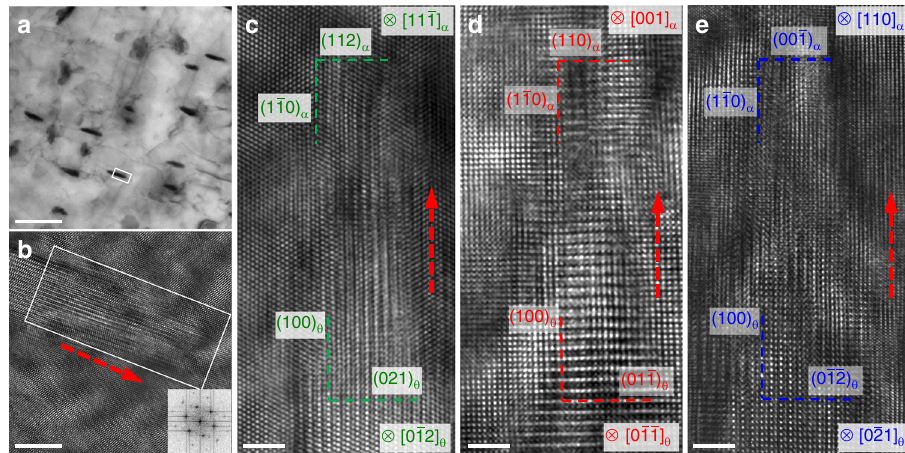
Fig. 1 Cementite nanoprecipitates in ferrite matrix. a Needle-shaped nanoprecipitates of cementite (black) with preferential growth direction in a ferrite matrix (gray). b An HRTEM image of the cementite precipitate in a enclosed by a rectangle. c – e HRTEM images of the atomic structures of the advancing tip of cementite precipitates from zone directions of ½ 11 (cid:1) 1 (cid:2) α , [001] α and [110] α , respectively. The red dashed arrows indicate projections of the actual growth direction onto different view planes. Scale bar in a , 100 nm; scale bar in b – e , 2